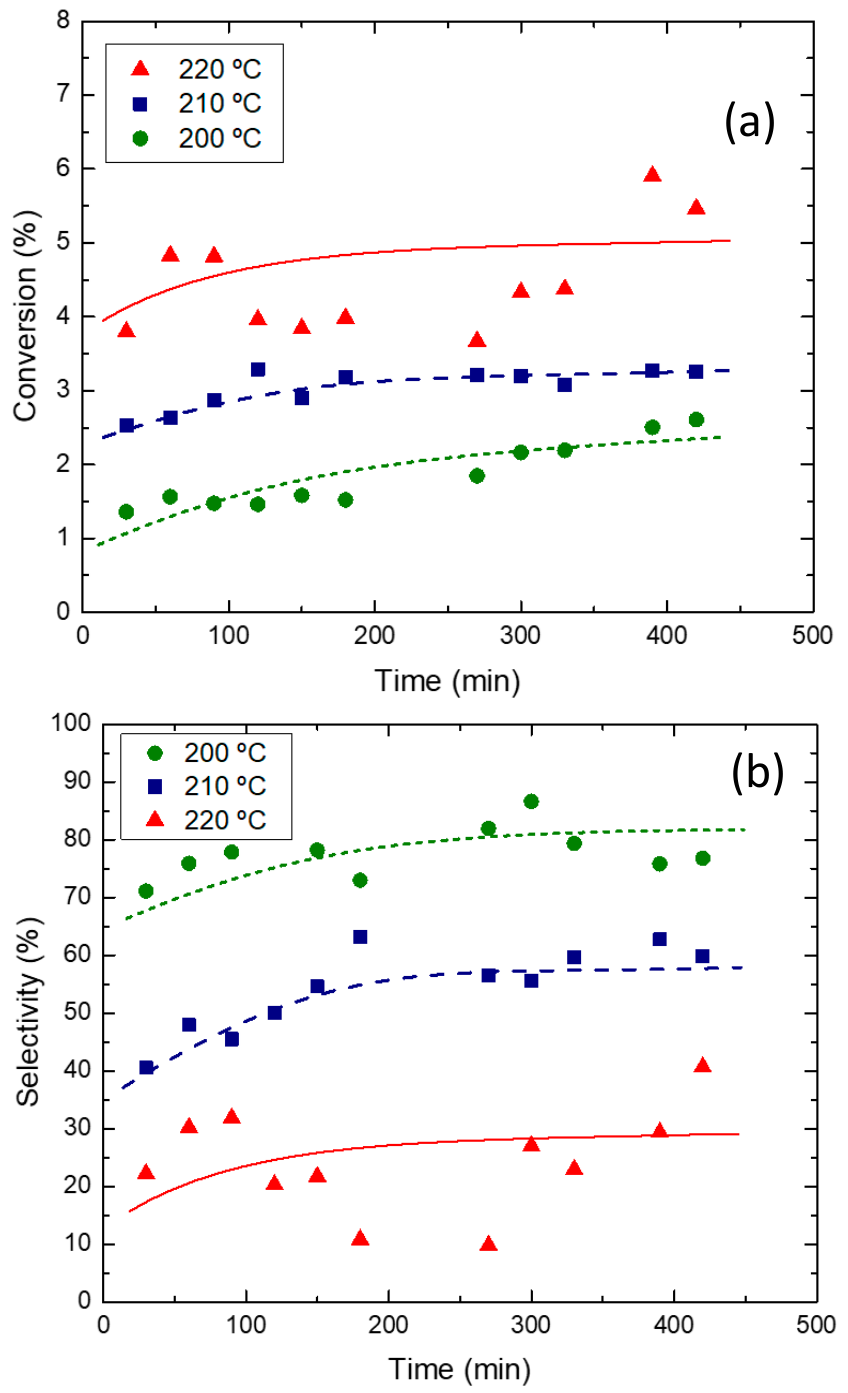
Figure 5. ( a ) Conversion and ( b ) selectivity for CZA-30 ́ at 5 bar.